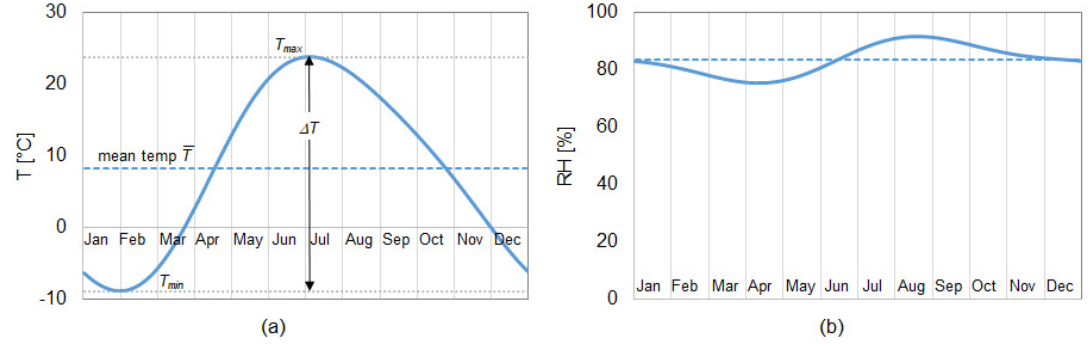
Figure 7. Annual variation of ( a ) temperature in ◦ C and ( b ) relative humidity of the air (courtesy of Hydro-Quebec).